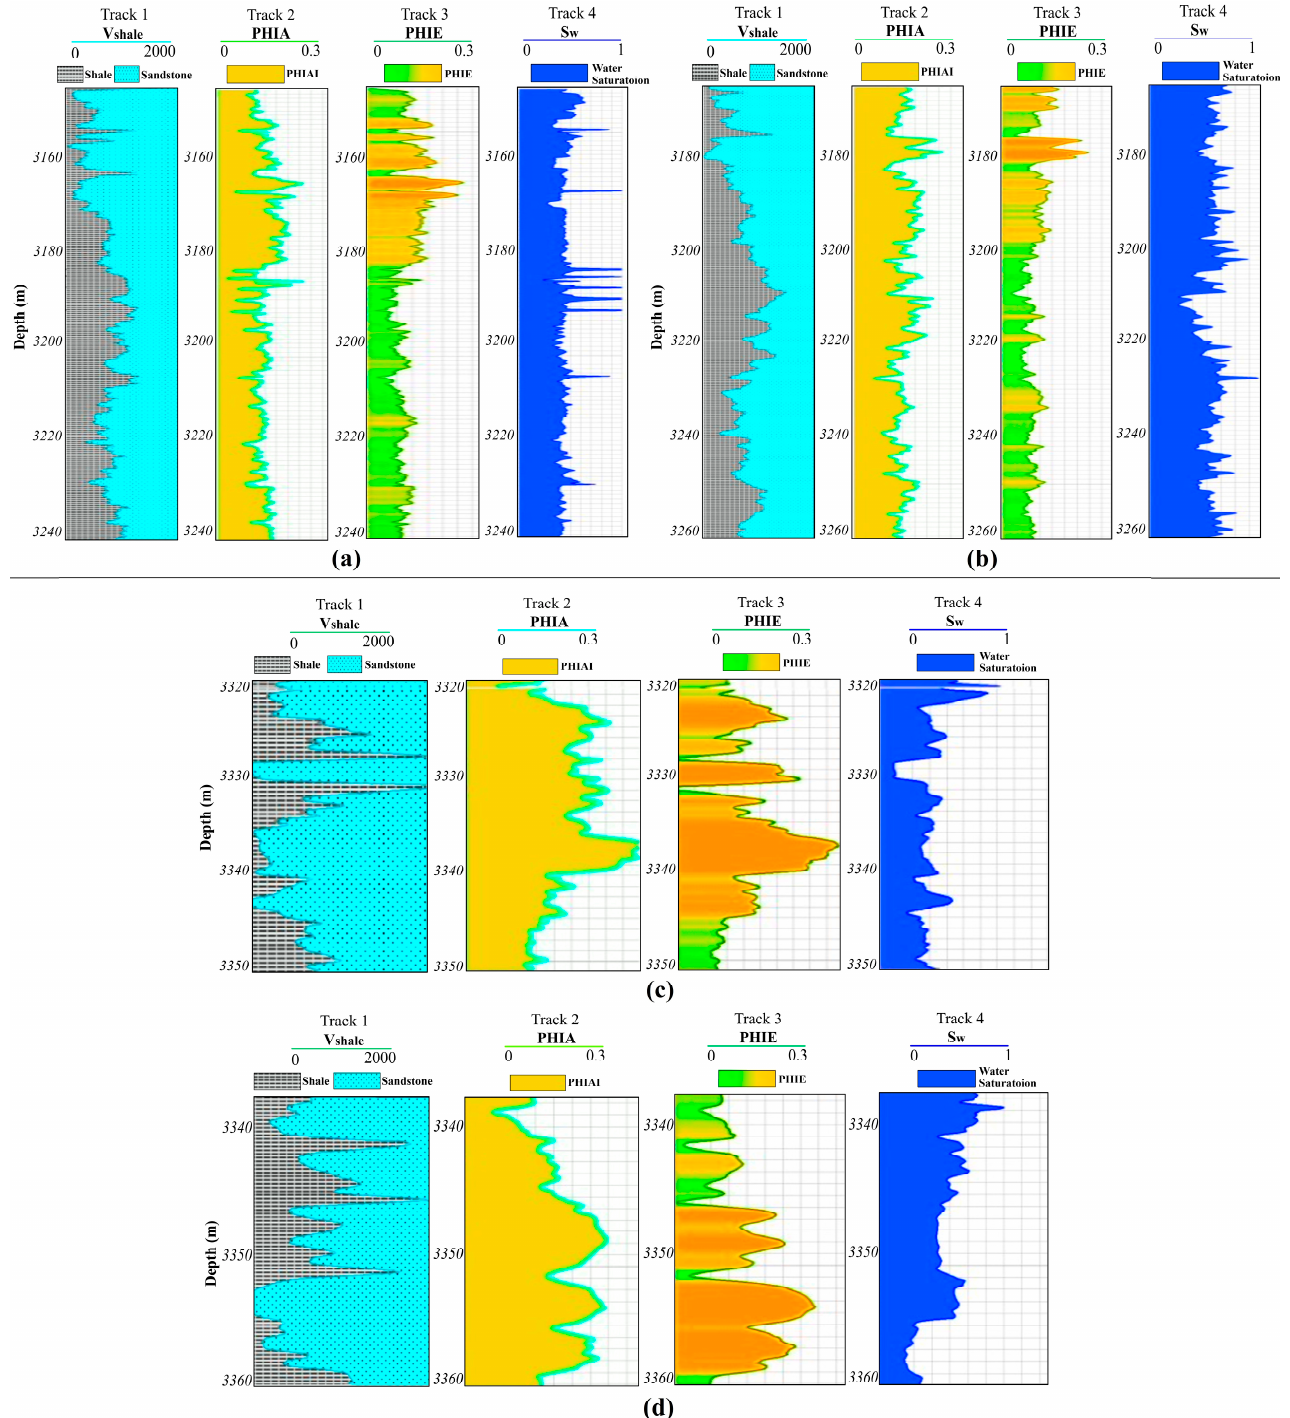
Figure 15. Relationship between the V shale and volume of sand (track 1), distribution of ∅ avg (track 2), distribution of ∅ eff (track 3), and the relationship between S W and S hc with respect to the depth at the G sand interval in ( a ) Kadanwari 10 and ( b ) Kadanwari-11 wells, and at the E sand interval in ( c ) Kadanwari 10 and ( d ) Kadanwari-11